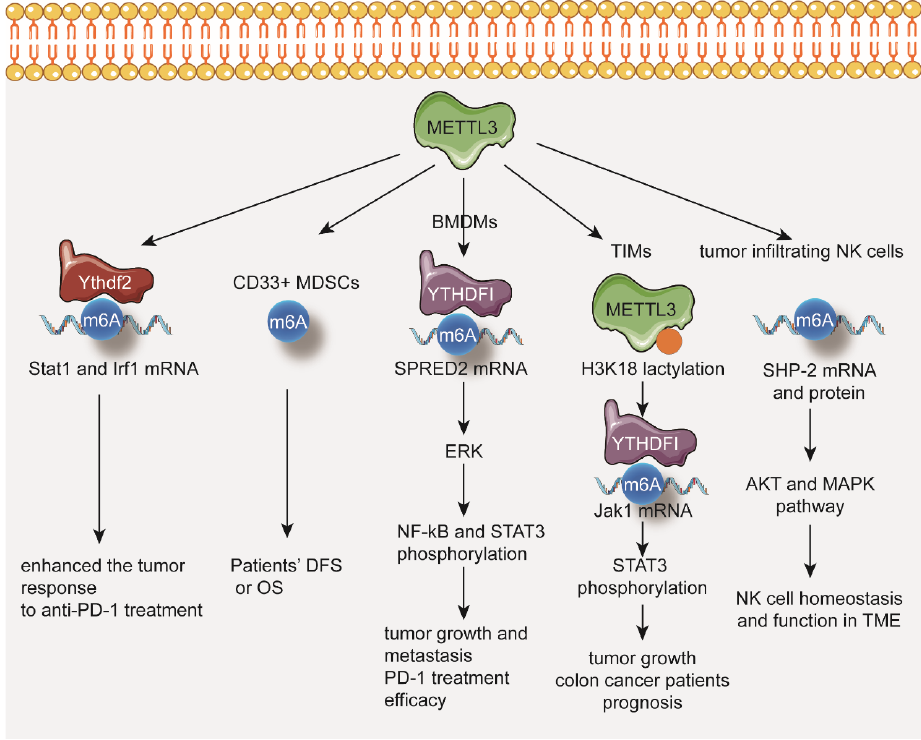
Figure 3. METTL3 in regulation of tumor immune